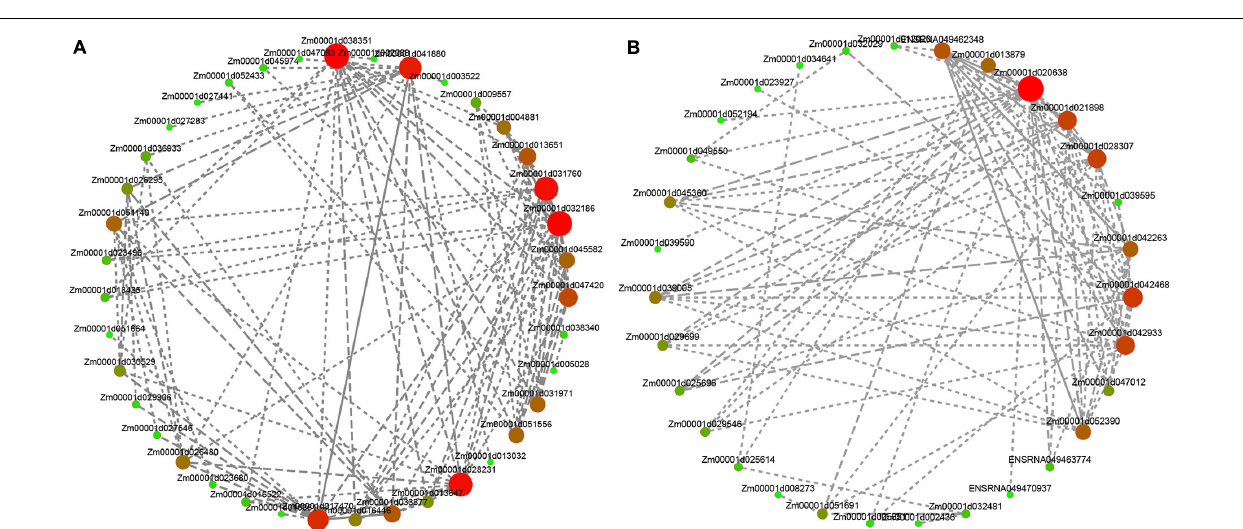
FIGURE 7 | Analysis of hub genes network interaction in phenotypic significant enrichment module. (A) Network interaction analysis of hub genes in purple module. (B) Network interaction analysis of hub genes in crimson module. The size and color gradient of the dots represent the high or low soft threshold of connectivity, with the redder color of the dots representing a higher soft threshold of